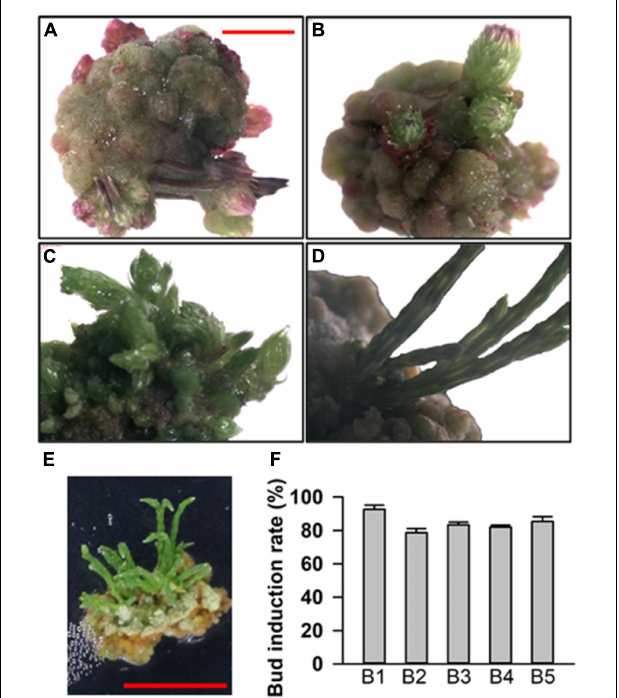
FIGURE 2 | Adventitious bud induction of callus. (A–D) Different stages of induced adventitious bud growth. (E) Adventitious buds on a callus. (F) Bud induction rate in basal medium with different plant growth regulator (PGR) combinations. The results are presented as the mean and standard error from three independent